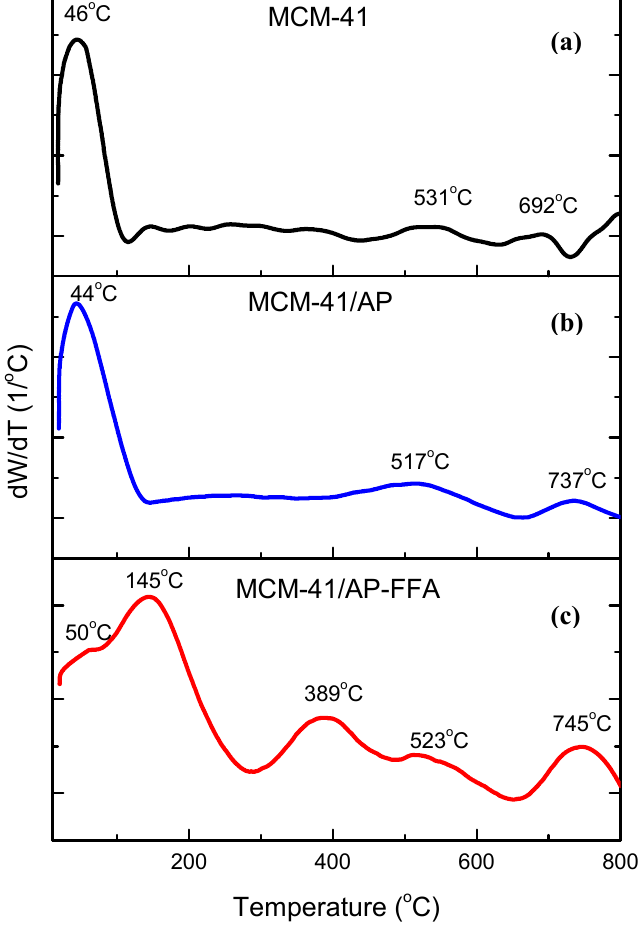
Figure 8. DTG of ( a ) MCM-41, ( b ) MCM-41/AP, and ( c ) MCM-41/AP-FFA.